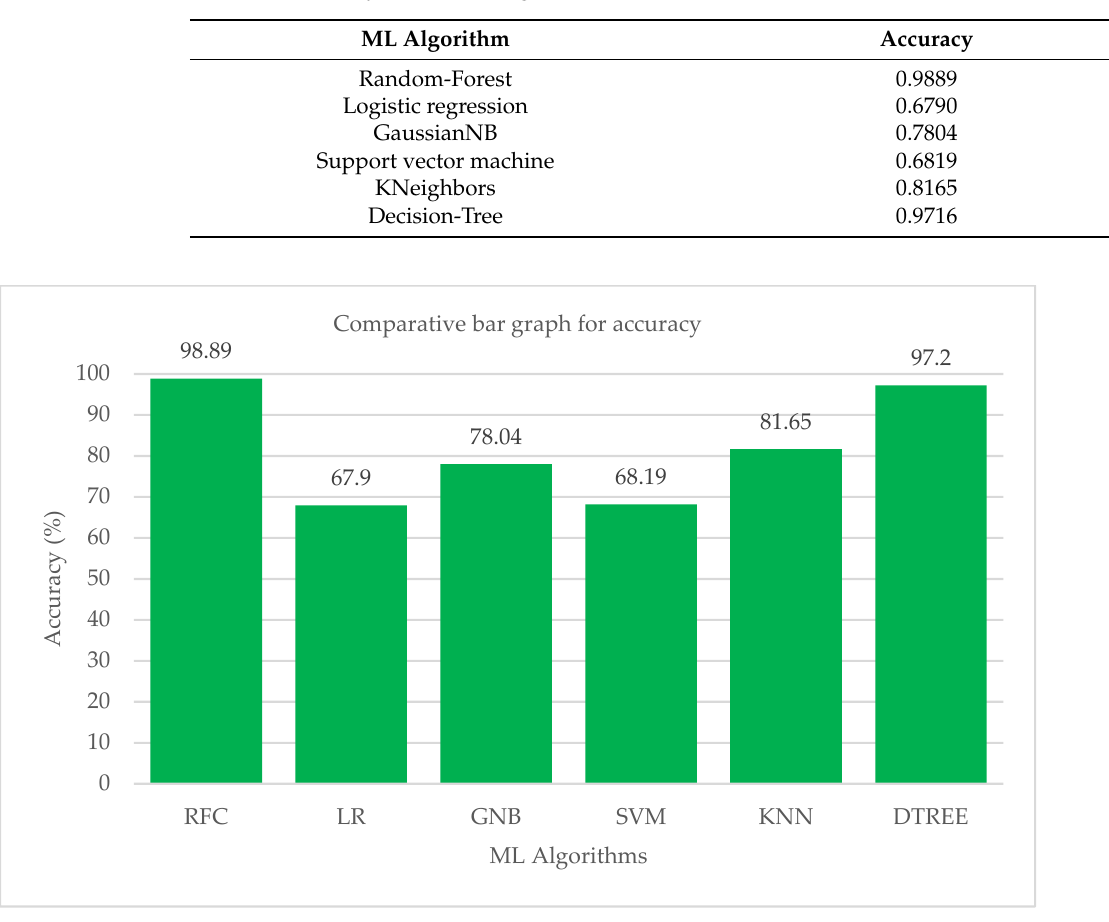
Figure 12. Bar chart visualization of accuracy comparison among different ML algorithms. The Random-Forest algorithm correctly and precisely predicted all of the ventilation Table 13. Accuracy of each ML algorithm. modes that were included in the study. After Random-Forest, the Decision-Tree method